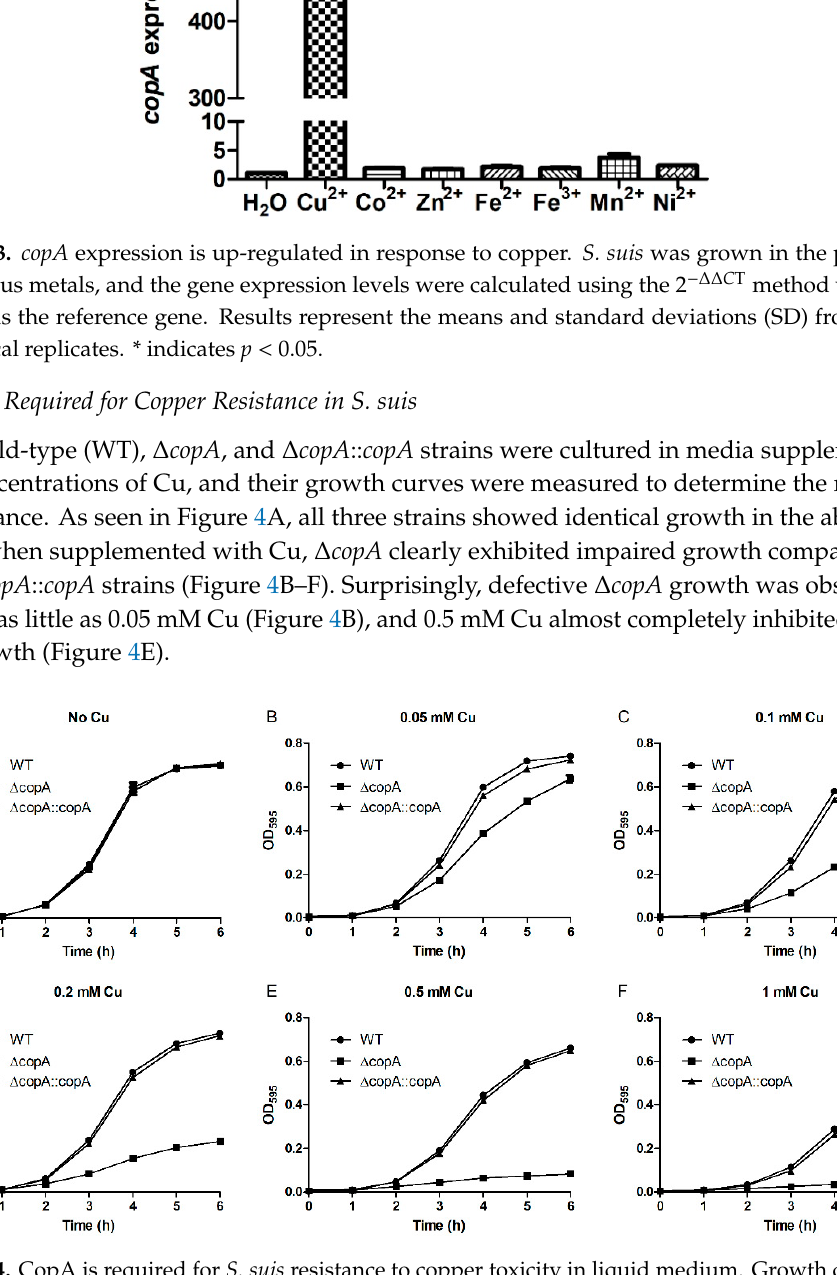
Figure 4. CopA is required for S. suis resistance to copper toxicity in liquid medium. Growth curves of the wildtype (WT), ∆ copA , and ∆ copA :: copA strains in the absence ( A ) and presence of 0.05 mM ( B ), 0.1 mM ( C ), 0.2 mM ( D ), 0.5 mM ( E ), and 1 mM ( F ) Cu. The data in the graphs are the means and SD from three wells.